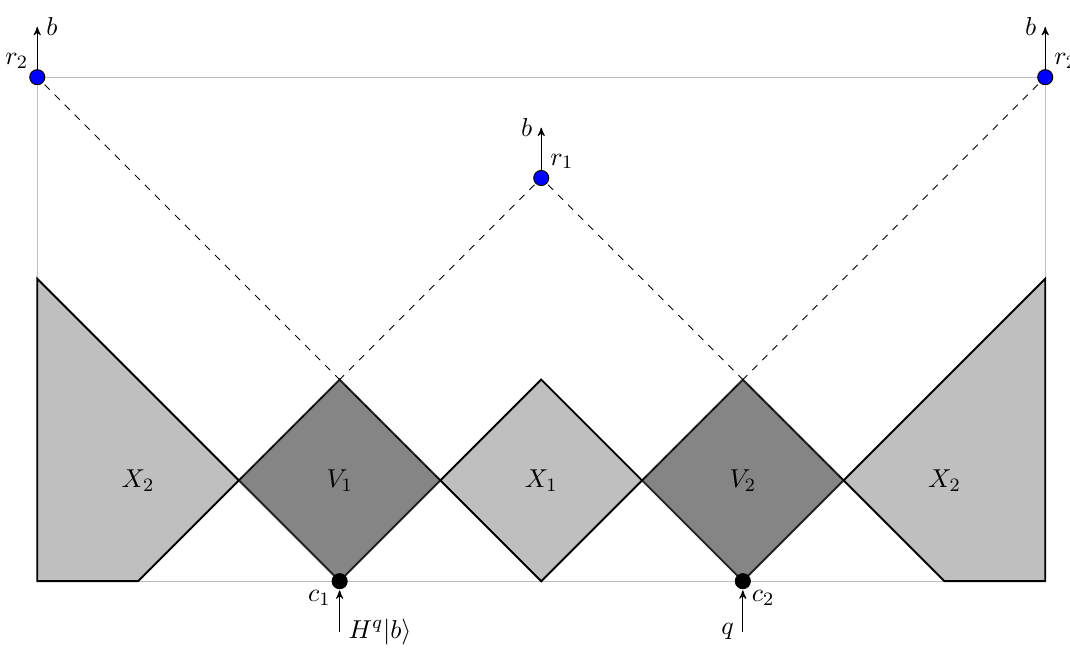
Figure 5. Boundary view of the B 84 task. Input regions V 1 and V 2 are shown in dark gray. The regions X i , shown in light gray, sit between the input regions and add some complications to the boundary proof of Theorem